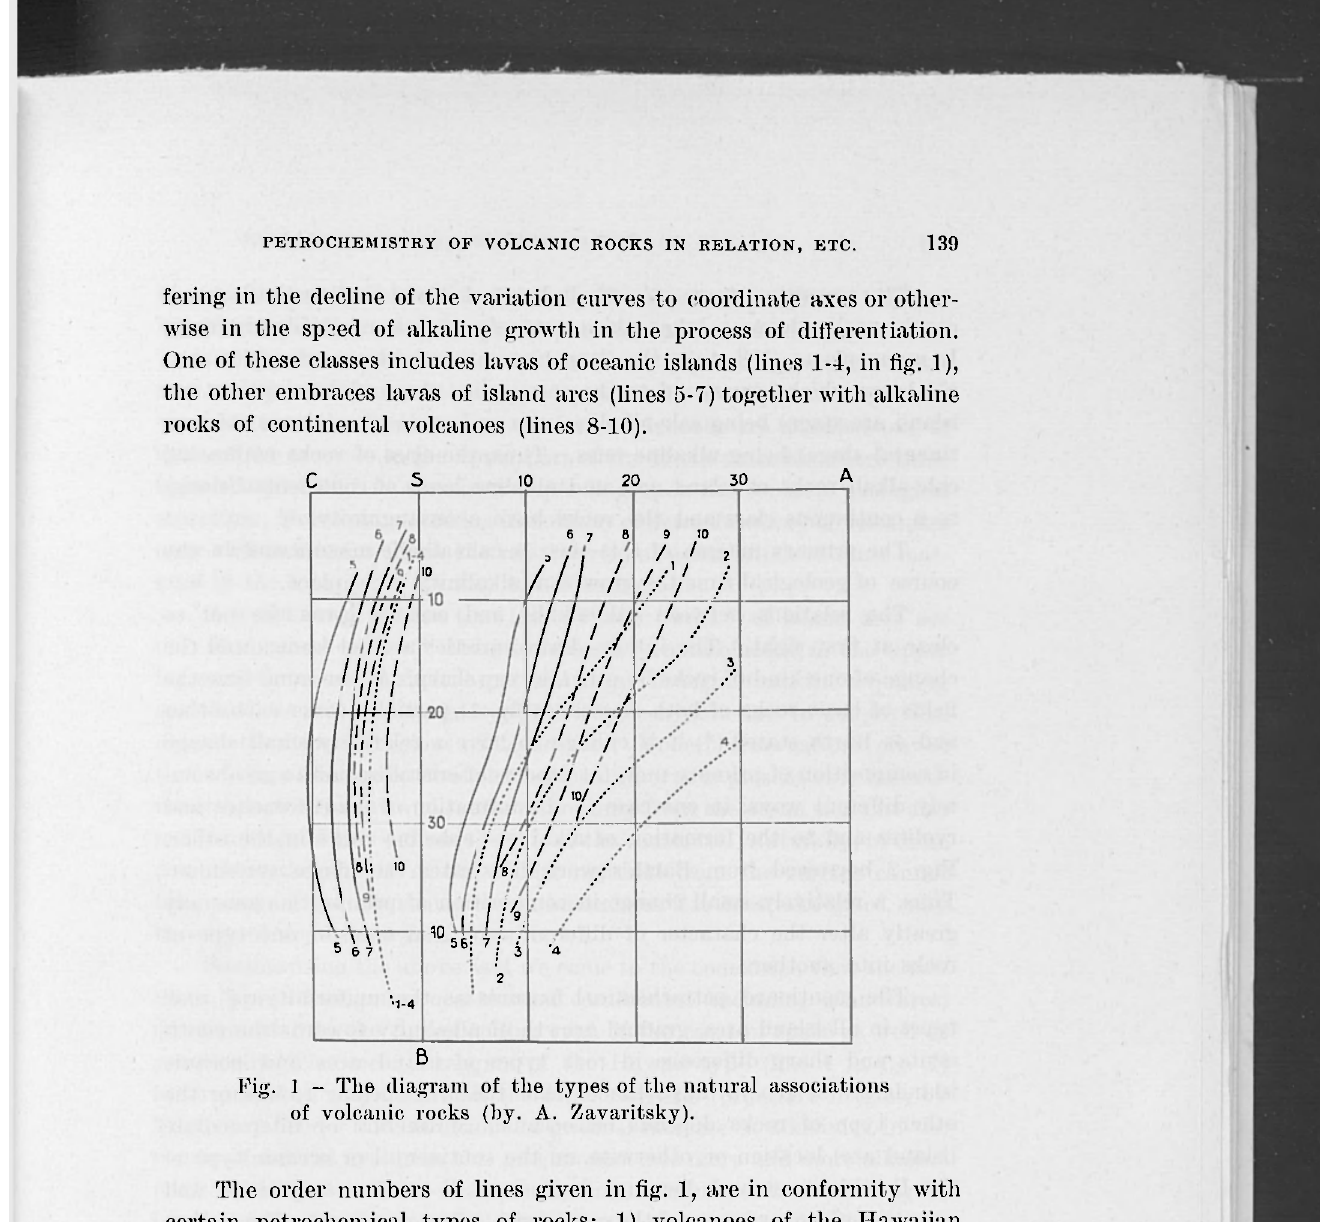
Fig. 1 - The diagram of the types of the natural associations of volcanic rocks (by. A.